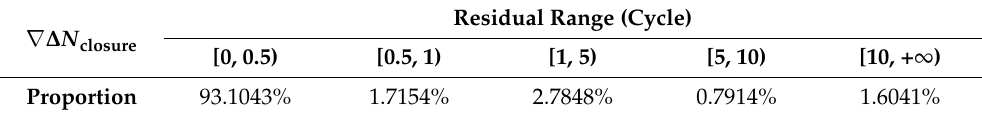
Figure 11. Ambiguity closure residual in the network. Table 4. The statistics of ∇ ∆ N closure .